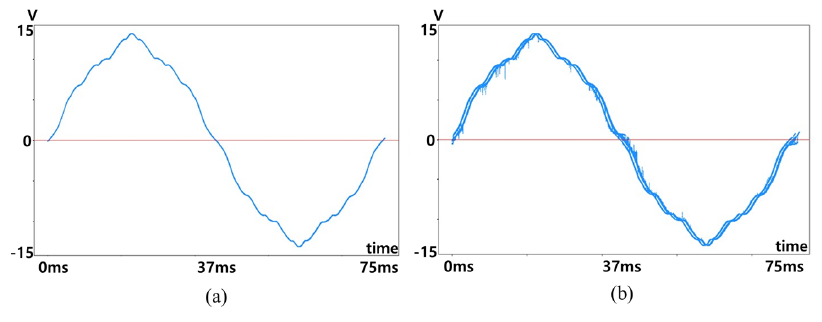
Figure 10. Back-EMF a-phase at 200